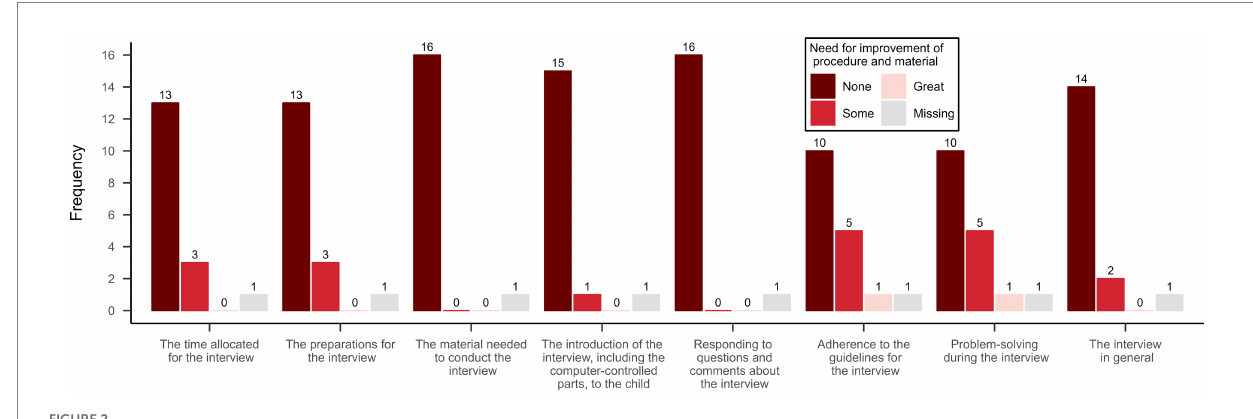
FIGURE 2 Interviewer rated need for improvement of procedure and